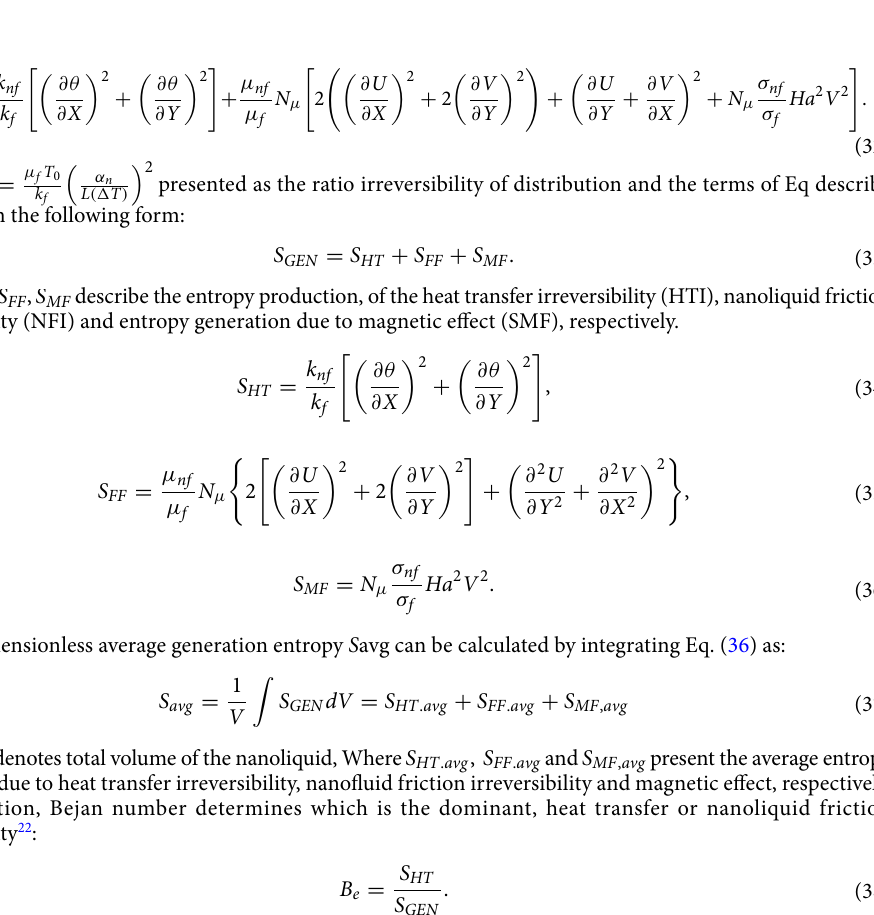
Table 1. Thermo-physical characteristics of base fluid (H 2 O) and nanoparticles (Al 2 O 3 ) 19